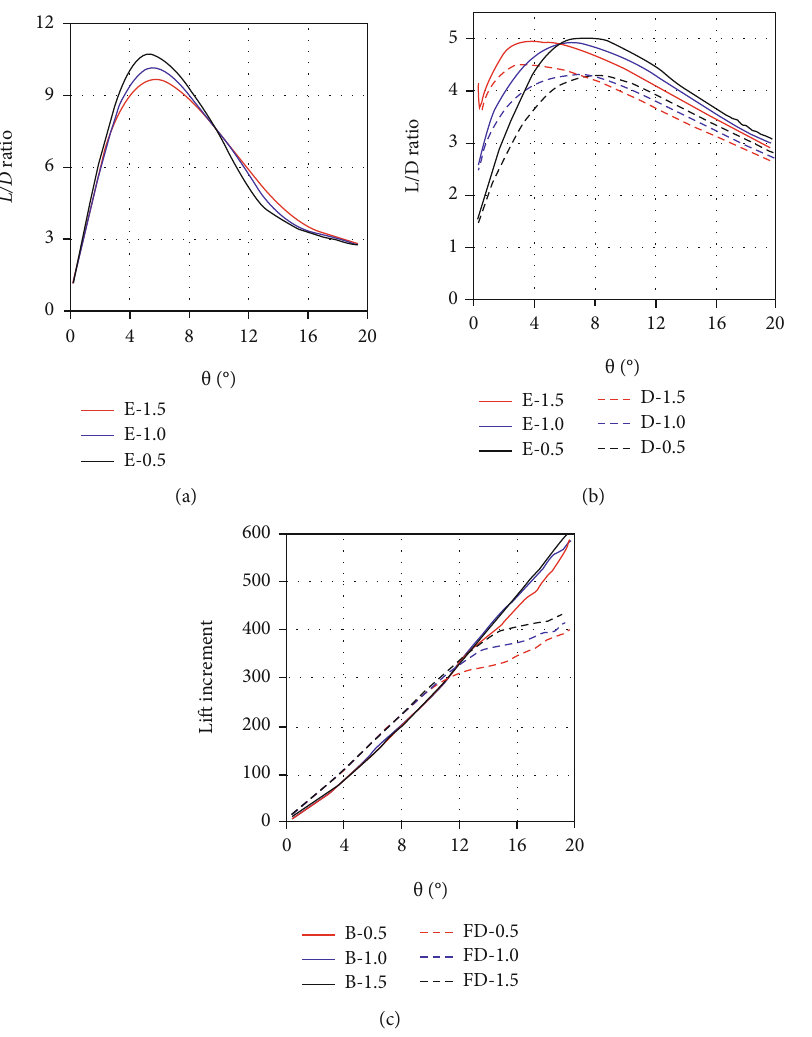
Figure 13: The L / D ratio and lift increment of the fi rst dorsal fi n and the body in the two morphing states with the yaw angular velocity of ω = 0 : 5 rad/s, 1rad/s, and 1.5rad/s: (a) the L / D ratio of the fi rst dorsal fi n; (b) the L / D ratio of the body; (c) the lift increment of the fi rst dorsal fi n and the